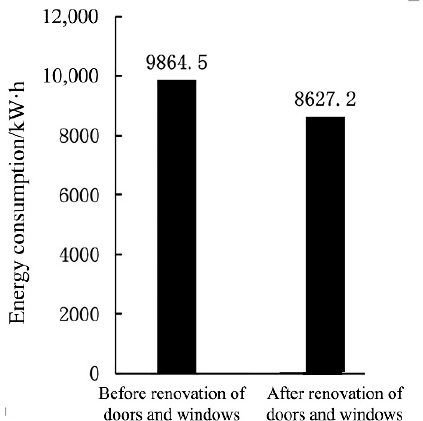
Figure 20. The simulated temperature of the master bedroom before and after renovation of doors and windows.